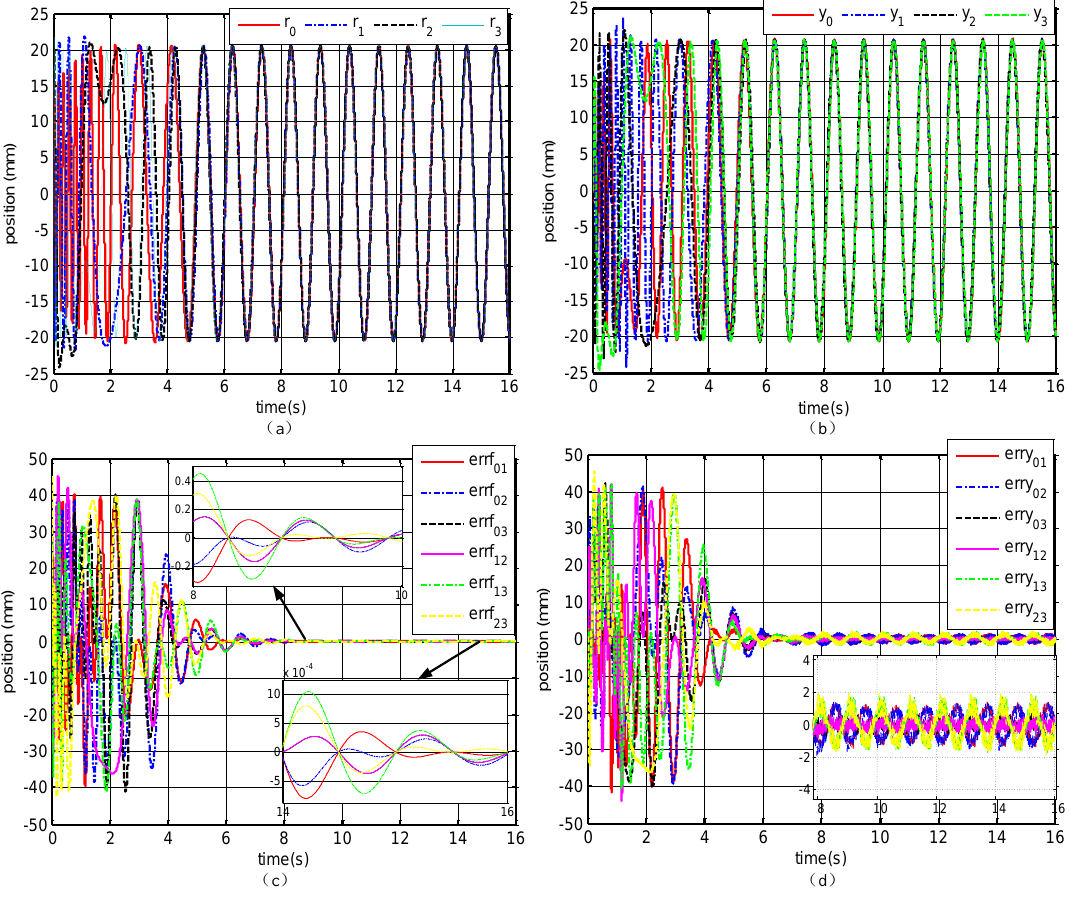
Figure 8. Dynamic position response waveforms: ( a ) reference, ( b ) actual and ( c ) relative reference, and ( d ) relative position signals under hierarchical